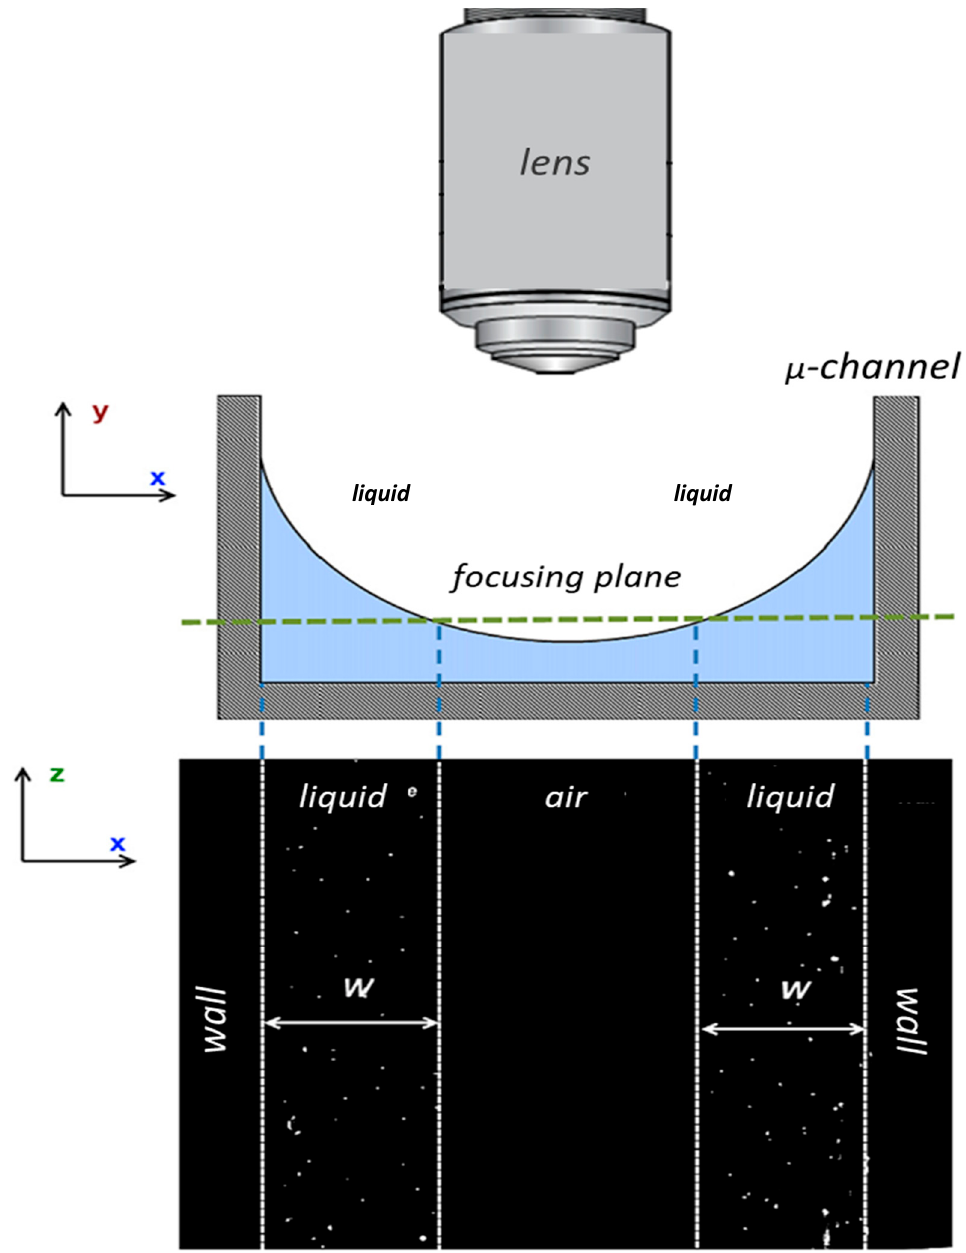
Figure 4. Identification of the liquid phase using fluorescent particles.